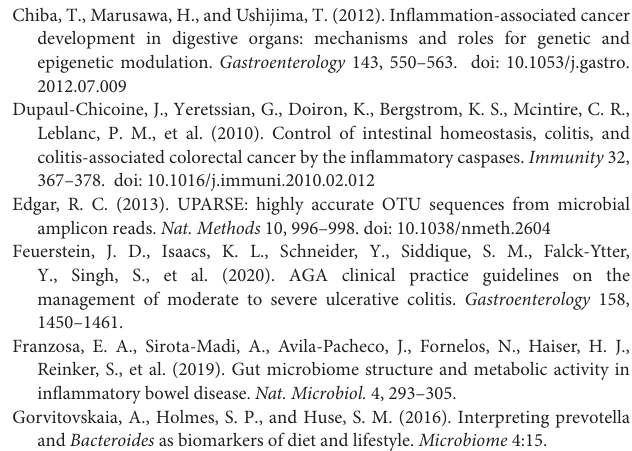
Supplementary Figure 1 | Rgmb-deficiency induced dysbiosis of gut microbiota in mice. (a) The schematic diagram represented inducible Rgmb knockout mice model. (b) The cladogram of evolution relationship between gut microbiota from Rgmb-deficient and control mice. (c) Heatmap represented the relative abundance of gut microbiota from Rgmb-deficient and control mice at genus level. (d) The species tree and distribution of gut bacterium at species level in Rgmb-deficient and control mice. (e) The relative abundance of gut microbiota in Rgmb-deficient and control mice at genus level. (f) The relative abundance of Prevotellaceae (left panel) and the ratio of Prevotellaceae to Muribaculaceae (right panel) in Rgmb-deficient and control mice at genus level. ∗ P < 0.05, ∗∗ P < 0.01. Supplementary Figure 2 | The relative abundance of gut microbiota in Rgmb-deficient and control mice at genus level. ∗ P < 0.05, n.s., not significant. Supplementary Figure 3 | The relative abundance of gut microbiota in Rgmb-deficient and wildtype CAC mice at genus level. (a) The schematic diagram represented Rgmb-knockout (Rgmb + / − ) and wildtype (Rgmb + / + ) mice model. (b) Heatmap represented the relative abundance of gut microbiota from Rgmb-deficient and wildtype mice at genus level. (c) The relative abundance of Prevotellaceae and the ratio of Prevotellaceae to Muribaculaceae in Rgmb-deficient and control mice at genus level. (d) Analysis of similarities (ANOSIM) between global Rgmb knockout and inducible Rgmb knockout mice. R = − 0.035, P = 0.496. (e) Heatmap represented the relative abundance of gut microbiota from Rgmb-deficient and wildtype CAC mice at genus level. (f) The relative abundance of Prevotellaceae and the ratio of Prevotellaceae to Muribaculaceae in Rgmb-deficient and control CAC mice at genus level. ∗∗ P < 0.01, n.s. not significant. Supplementary Table 1 | Correlation statistics between gut microbiota and inflammation of Rgmb-deficient mice with